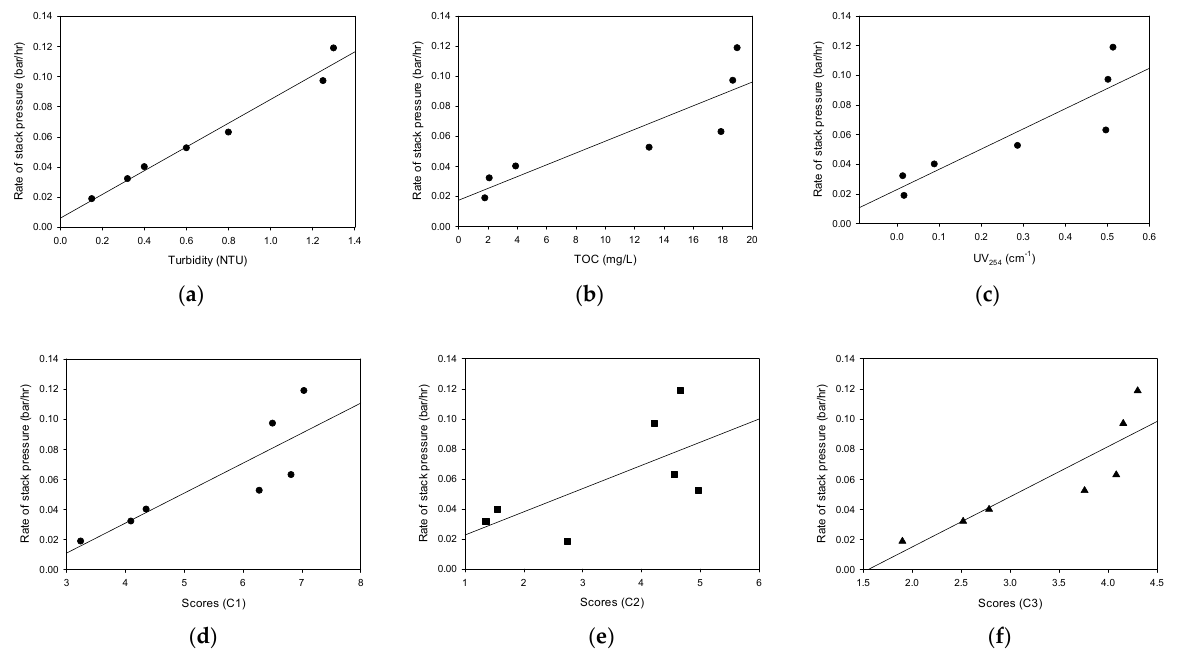
Figure 11. Correlations between water quality parameters and stack pressure: ( a ) turbidity; ( b ) TOC; ( c ) UV254; ( d ) PARAFAC Score 1; ( e ) PARAFAC Score 2; ( f ) PARAFAC Score 3.